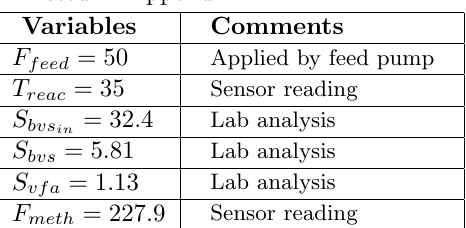
Figure 4: Upper plot: Measured feed flow. Lower plot: Measured (blue) and simulated (red) methane gas flow. Table 5: Values of inputs and states in the steady-state operation point ( t = 66 d; t = 0 = 19. April 2012) used for model adaption. Units are listed in Appendix